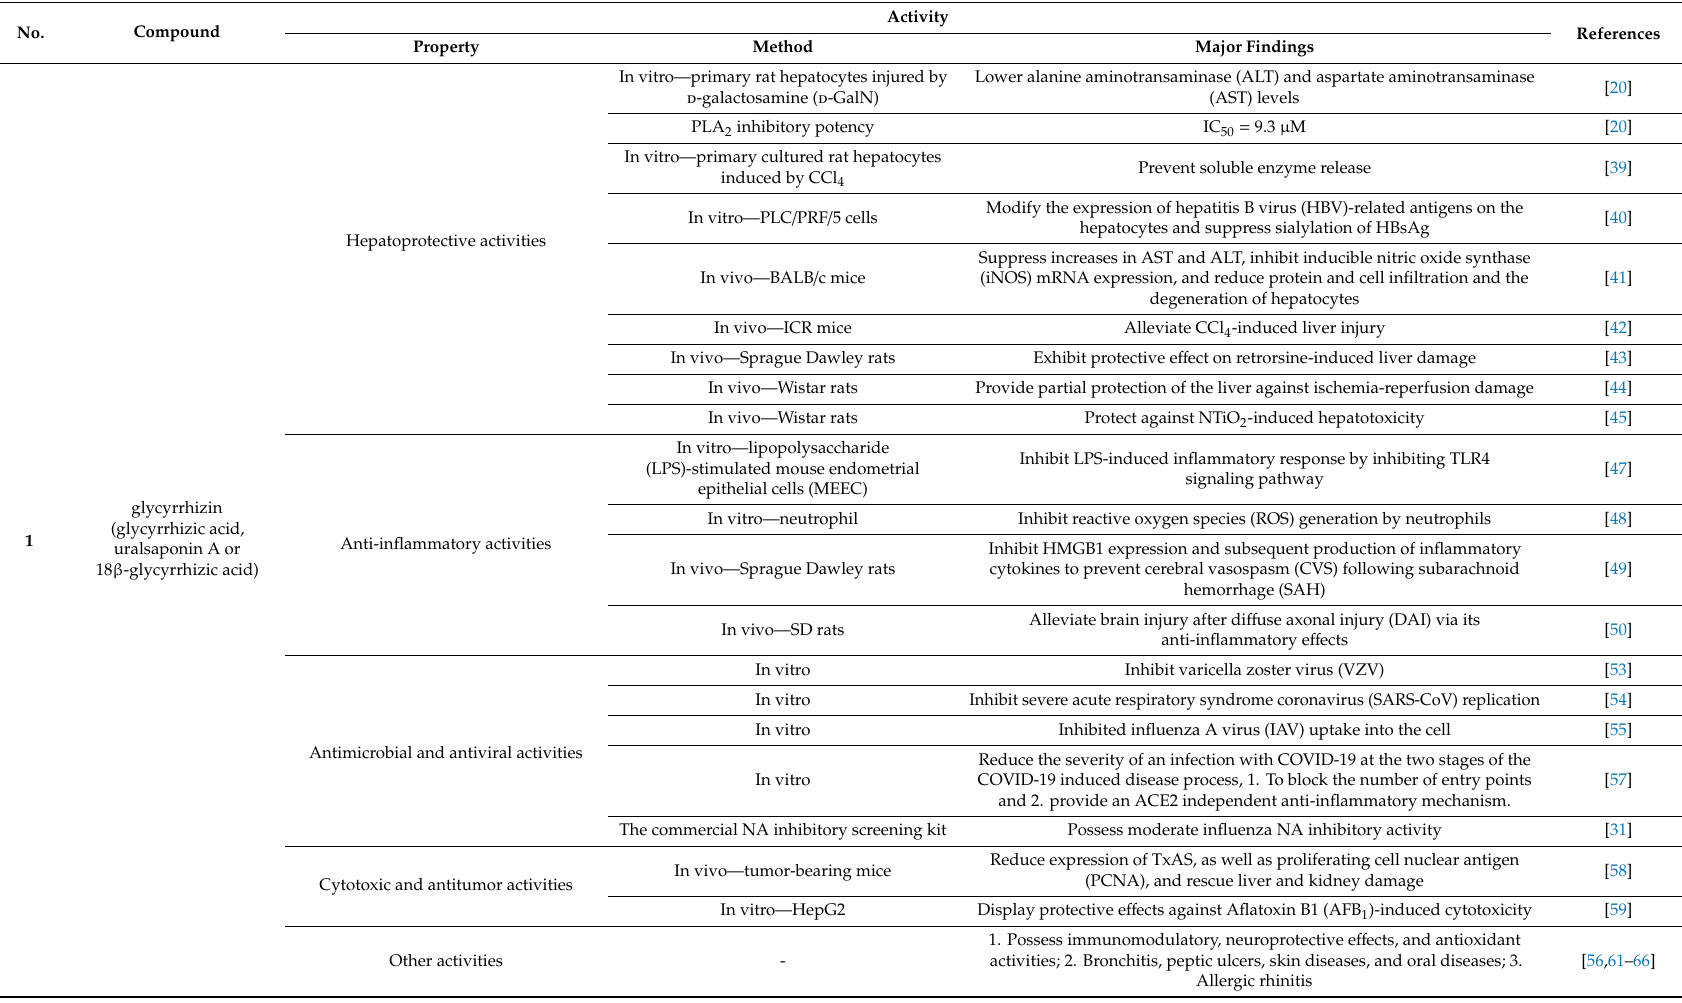
Table 2. Summary of the biological activities conducted with triterpene saponins in glycyrrhiza 1